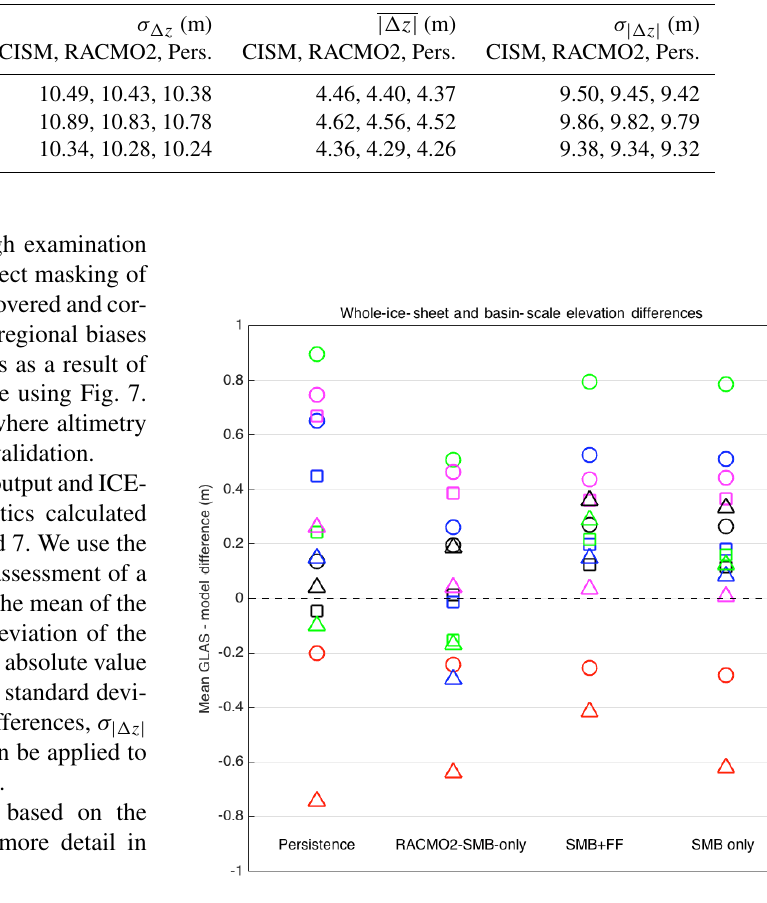
Figure 8. Summary plot for whole-ice-sheet- and basin-scale- specific mean elevation differences (GLAS minus model, in me- ters). Circles, squares, and triangles are for years 2003.8, 2004.8, and 2007.8, respectively. Colors represent different ice sheet ar- eas as follows: entire ice sheet (black), Jacobshavn drainage basin (blue), Kangerlussuauaq drainage basin (red), Helheim drainage basin (green), and the northwest coast drainage basin (magenta). For 2004.8, all Kangerlussuauaq basin comparisons (missing red squares) plot at around − 2 . 25m, and are omitted here for clarity of plotting. Drainage basin areas are identical to those defined by IMBIE (Shepherd et al.,